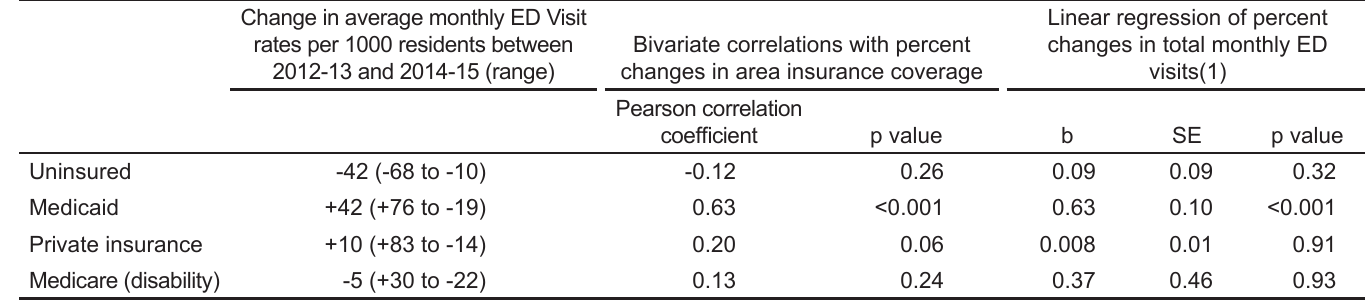
ED ,emergency department; SE , standard